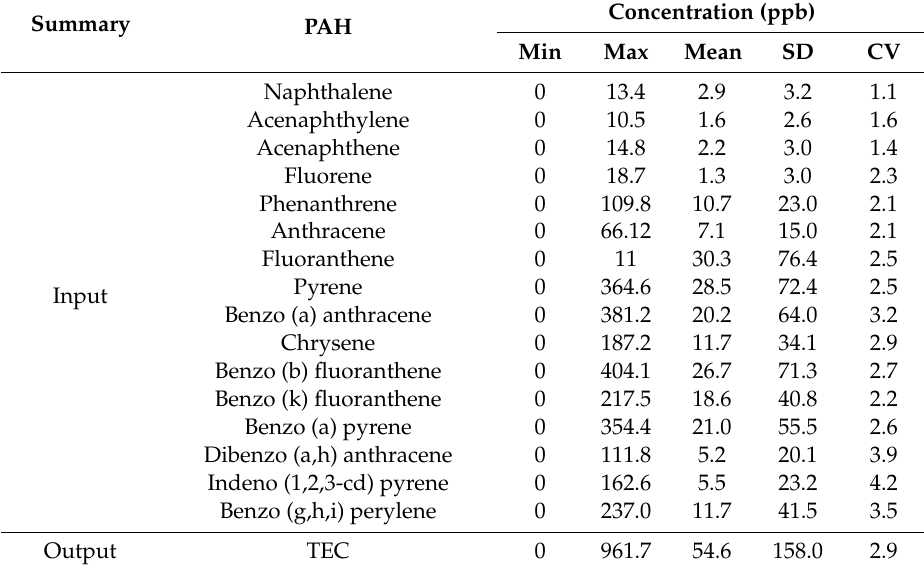
Table 12. Summary of the input and output parameters for the dry season.